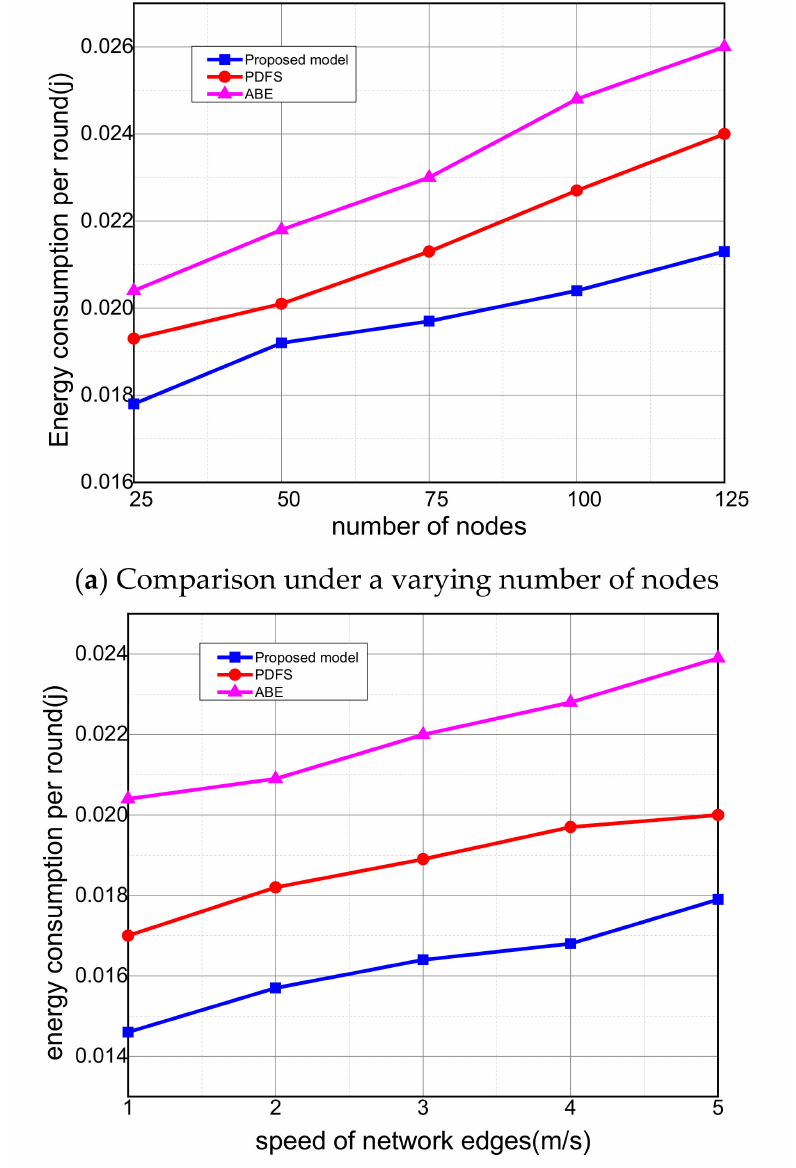
Figure 5. Evaluation of energy consumption among proposed model, PDFS,